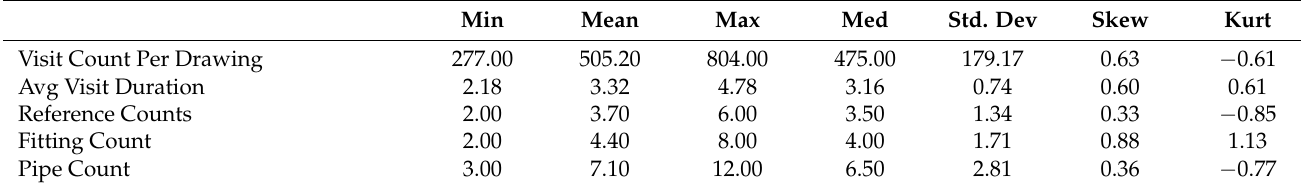
Table 5. Descriptive statistics—assembly drawings (N =10).